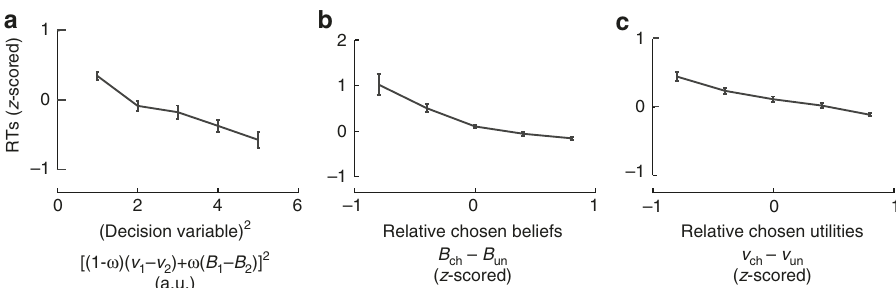
Fig. 6 Reaction time analysis. Reaction times (RTs) plotted against the quadratic expansion of decision variable ( a ), relative chosen state beliefs ( b , z - scored within participants) and relative chosen normalised utilities ( c , z -scored within participants). Error bars are s.e.m. across participants ( N = 22). These analyses of RTs, which constitute a dataset independent of both fMRI activations and choice data used for model fi tting validate the approach used to investigate fMRI. Indeed, our fi rst regression analysis of fMRI activations assumes that decision-making is more demanding when the decision variable becomes more ambiguous, thereby predicting RTs to vary as a quadratic function of decision variable (i.e., with − [(1 − ω )( v 1 − v 2 ) + ω ( B 1 − B 2 )] 2 ). Consistently, RTs decreased with quadratic regressor [(1 − ω )( v 1 − v 2 ) + ω ( B 1 − B 2 )] 2 ( a : T (21) = 6.6; p <0.0001). Our second regression analysis of